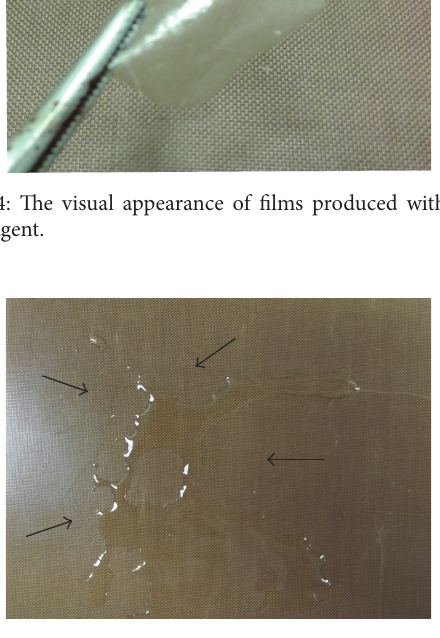
Figure 5: The visual appearance of films produced with NH 4 F as catalyst